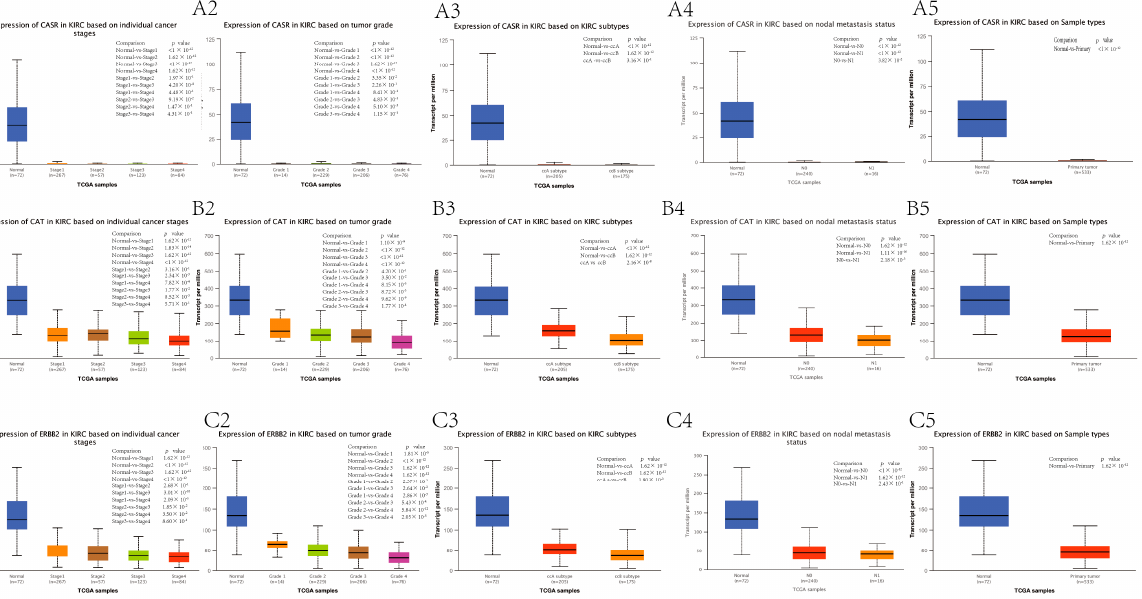
Figure 7. The correlation between the expression of hub genes and clinicopathological features. ( A1 – A5 ) Box diagrams visualize the expression of CASR in different clinical stages ( A1 ), pathological grades ( A2 ), subtypes ( A3 ), numbers of metastatic lymph nodes ( A4 ), and tissues ( A5 ). ( B1 – B5 ) Box diagrams visualize the expression of CAT in different clinical stages ( B1 ), pathological grades ( B2 ), subtypes ( B3 ), numbers of metastatic lymph nodes ( B4 ), and tissues ( B5 ). ( C1 – C5 ) Box diagrams visualize the expression of ERBB2 in different clinical stages ( C1 ), pathological grades ( C2 ), subtypes ( C3 ), numbers of metastatic lymph nodes ( C4 ), and tissues ( C5 ). ( D1 – D5 ) Box diagrams visualize the expression of TIMP1 in different clinical stages ( D1 ), pathological grades ( D2 ), subtypes ( D3 ), numbers of metastatic lymph nodes ( D4 ), and tissues ( D5 ). ( E1 – E5 ) Box diagrams visualize the ex- pression of P2RY8 in different clinical stages ( E1 ), pathological grades ( E2 ), subtypes ( E3 ), numbers of metastatic lymph nodes ( E4 ), and tissues ( E5 ). ( F1 – F5 ) Box diagrams visualize the expression of